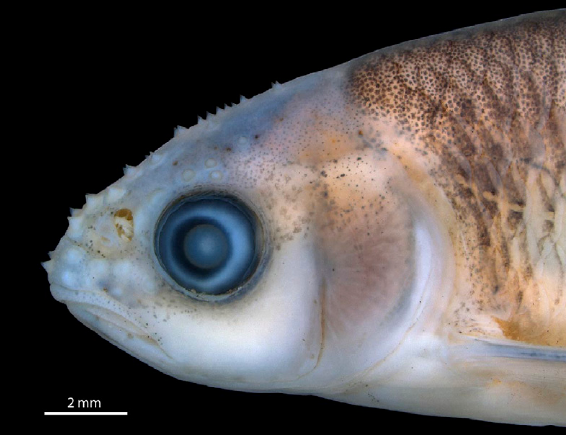
Figure 4. Cyprinella panarcys , TCWC 19724.01, male, 36.0 mm SL; head in lateral